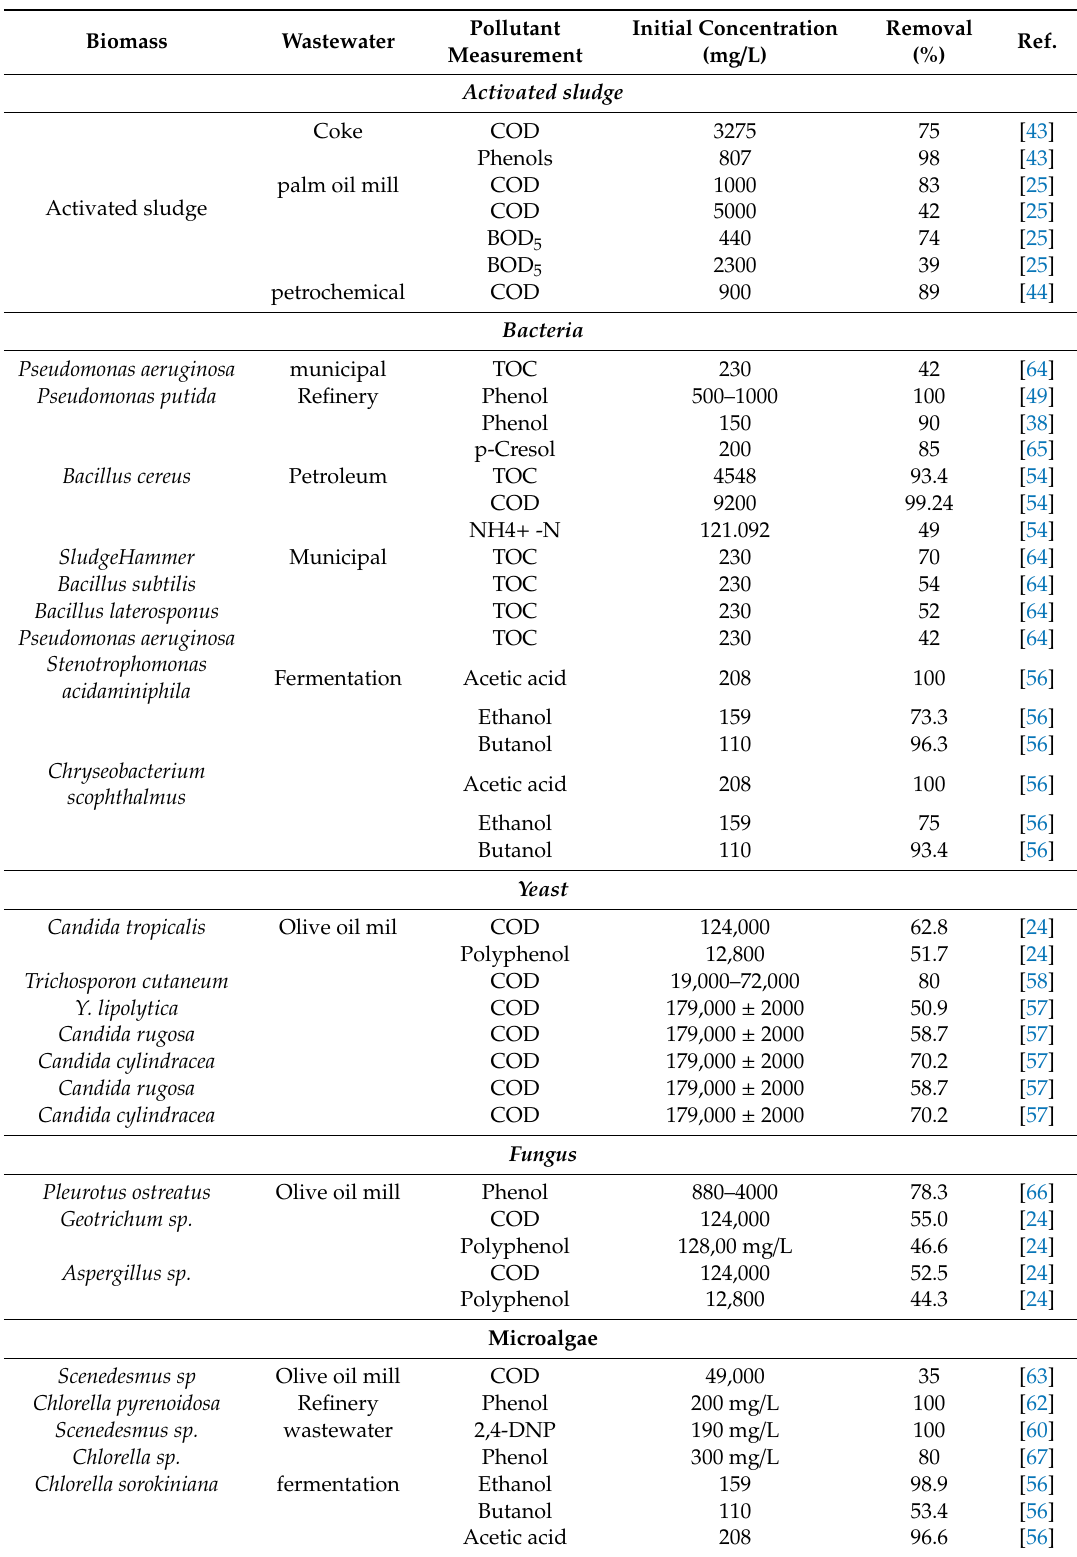
Table 2. Aerobic biodegradation of industrial wastewater using several microorganisms.